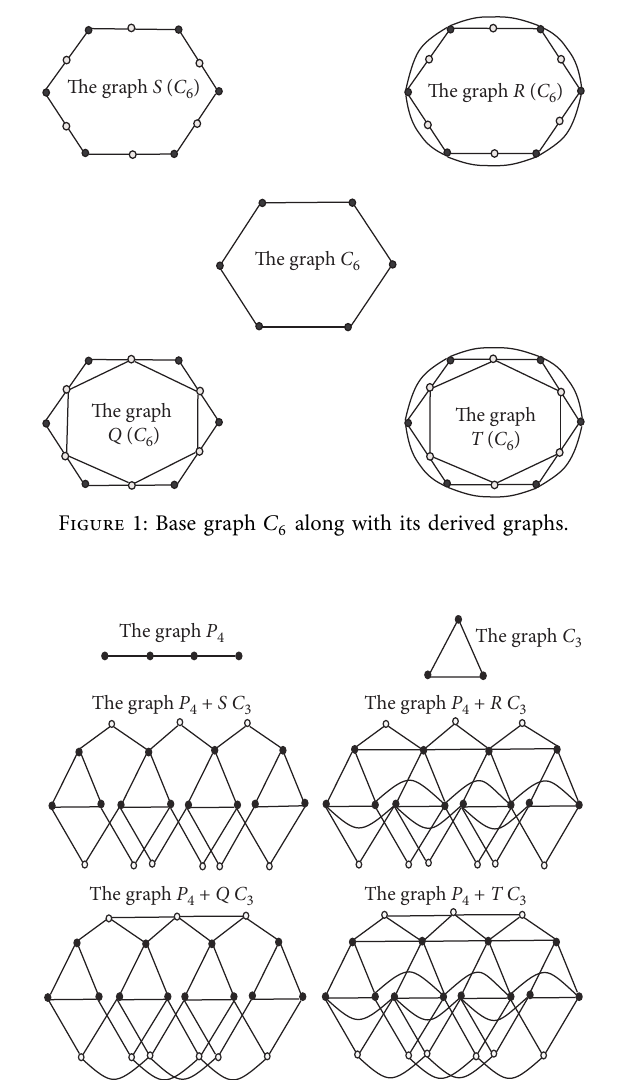
Figure 2: Graphs P